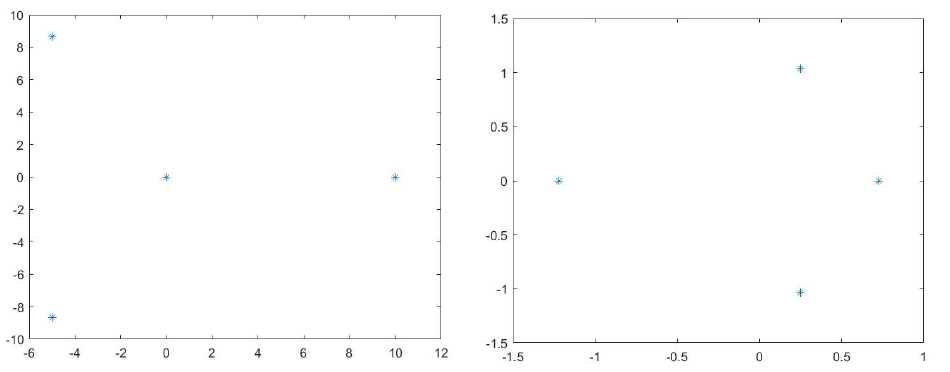
Figure 3. Root evolution for λ = − 1 ( left ) and λ = − 10 ( right ). To this end, a = 1, with χ 1 < (cid:101) → 0 and | x | δ (cid:101) = 1. It shall be noted that there exists at least one root Re ( s ) >